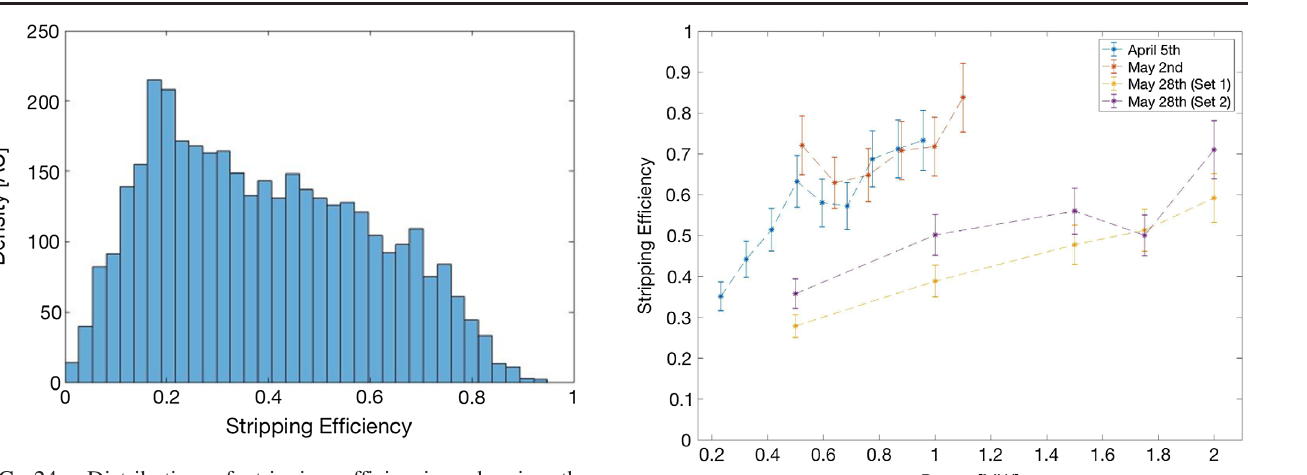
FIG. 24. Distribution of stripping efficiencies, showing the impact of the laser jitter.